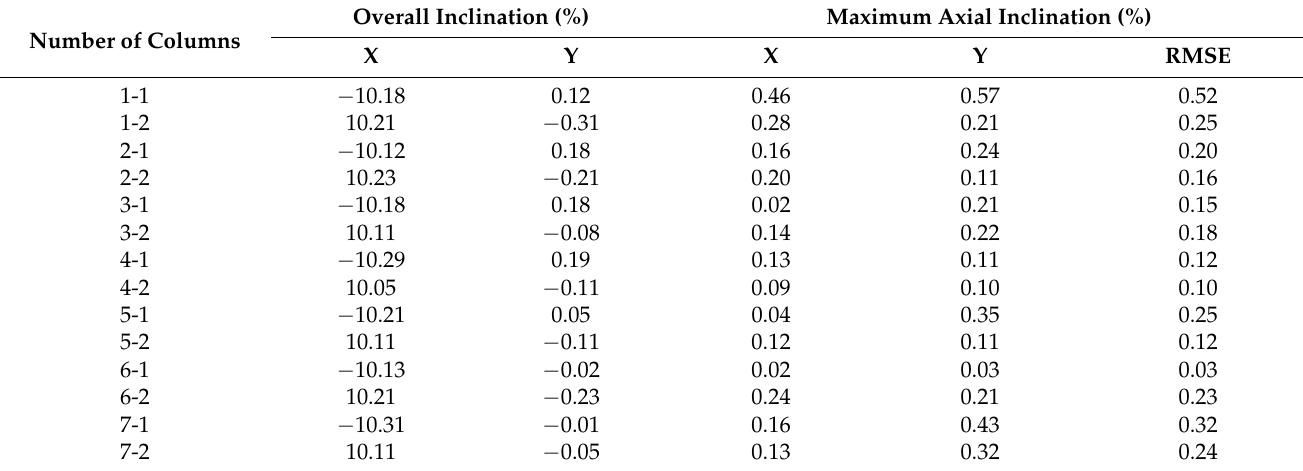
Table 4. Inclinations of each column by total